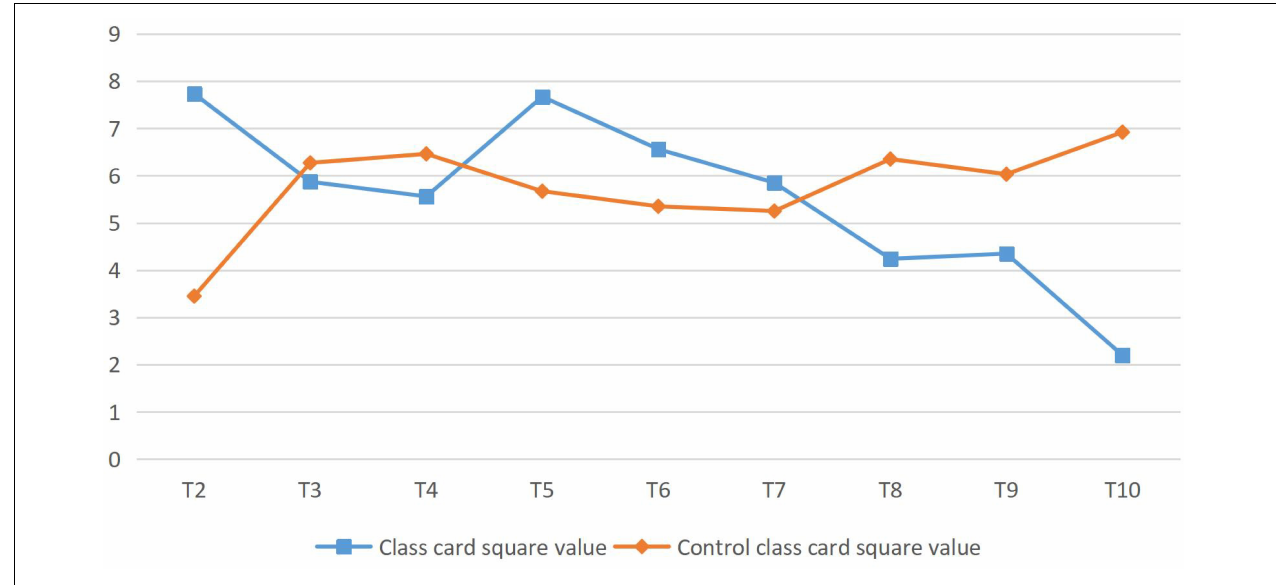
FIGURE 3 | Analysis of students’ learning interest and attitude